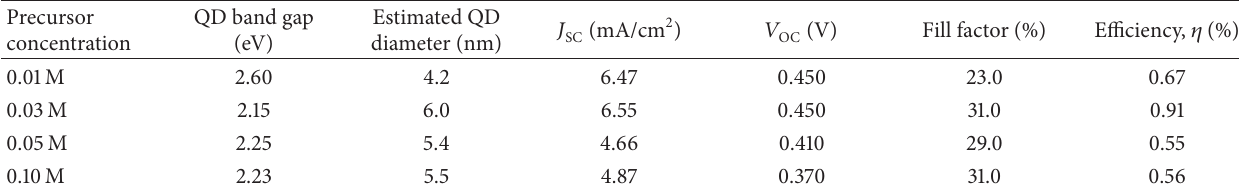
Table 2: The energy gap and size of QDs and QDSSC performance parameters for CdSe QDs prepared using different precursor concentrations.